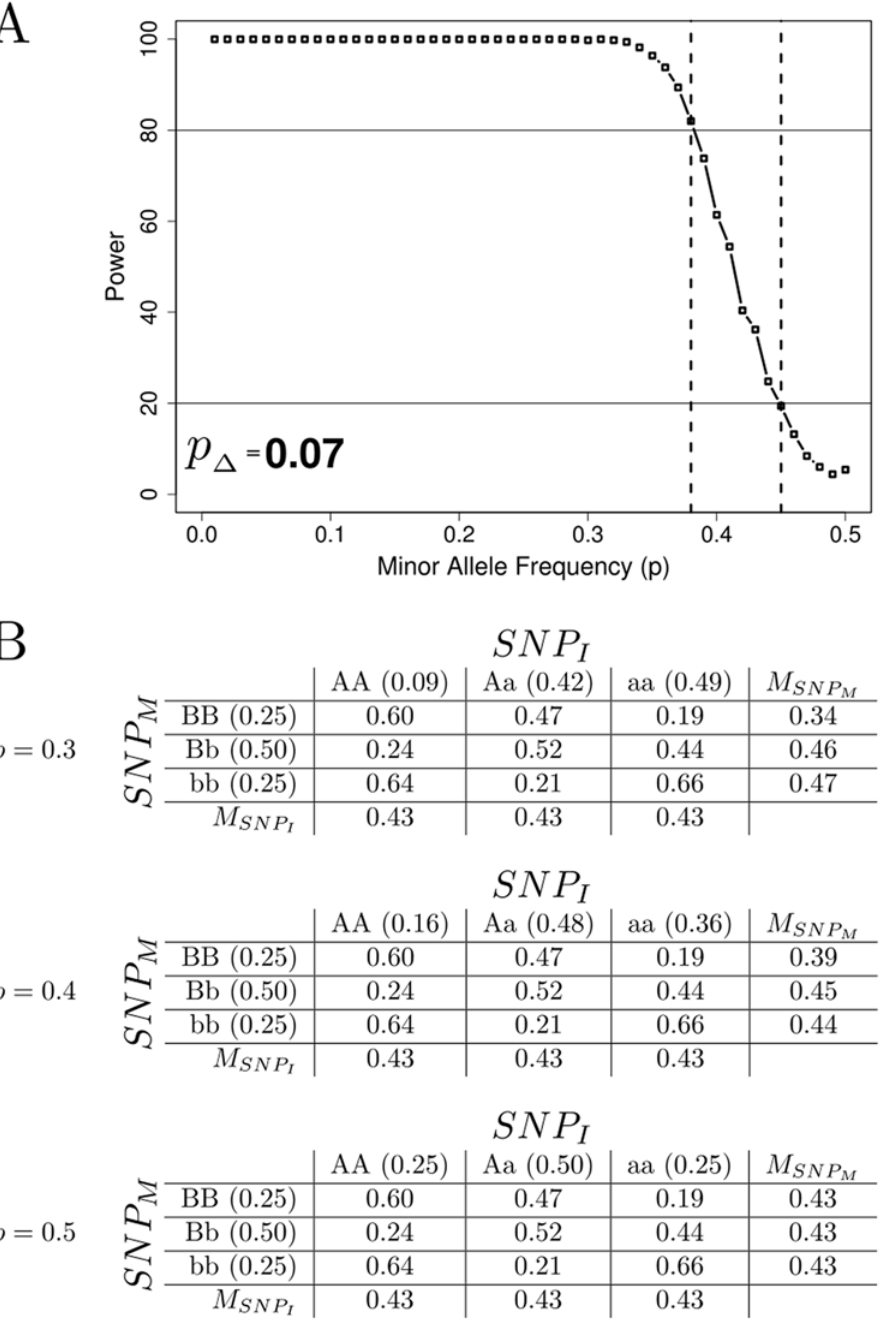
[20]. When the study was repeated in Italian patients, no correlation was observed and allele frequency differences were cited as a potential explanation for non-replication [21]. More